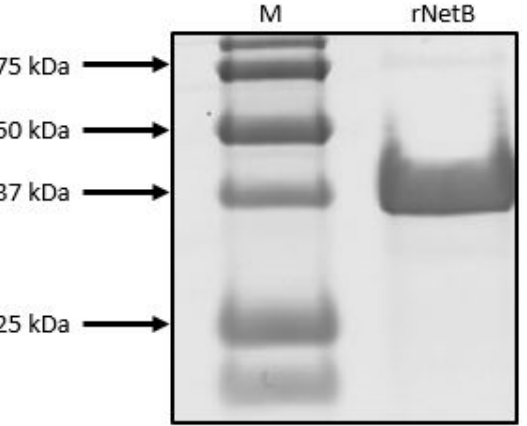
Figure 1. SDS-PAGE of purified recombinant NetB. The purified protein (rNetB) was separated by 12% SDS-PAGE and Precision Plus Protein™ Standard (BioRad) was used as a size marker (M). SDS-PAGE was stained with Brilliant Blue G; band representing rNetB appears at the expected size of 33 kDa.